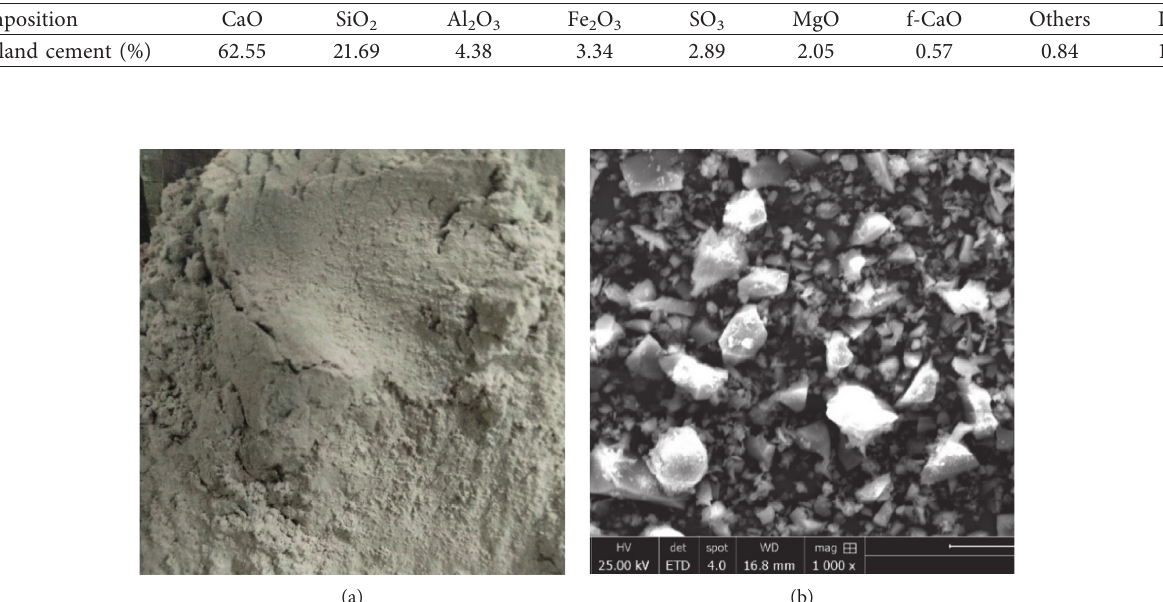
Table 3: Chemical composition of common Portland cement (PO 42.5).